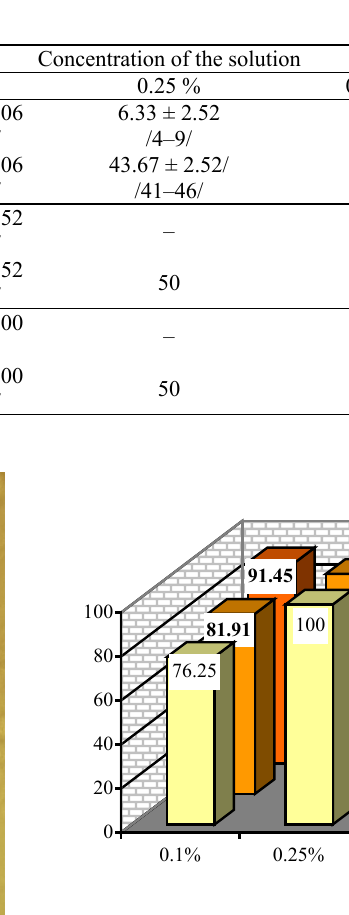
Indicators of the ovocidal activity of “Virosan” against Passalurus ambiguus eggs during their embryogenesis in laboratory conditions (M ± SD, min-max)